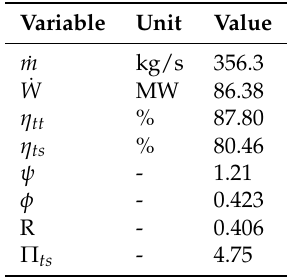
Table 11. 3D CFD performance results for the isolated